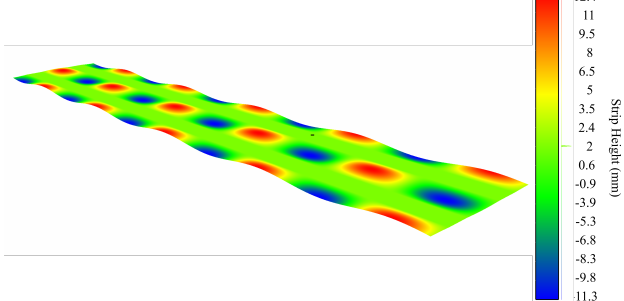
Figure 7. A noise-free synthetic surface showing center buckles and wavy edge